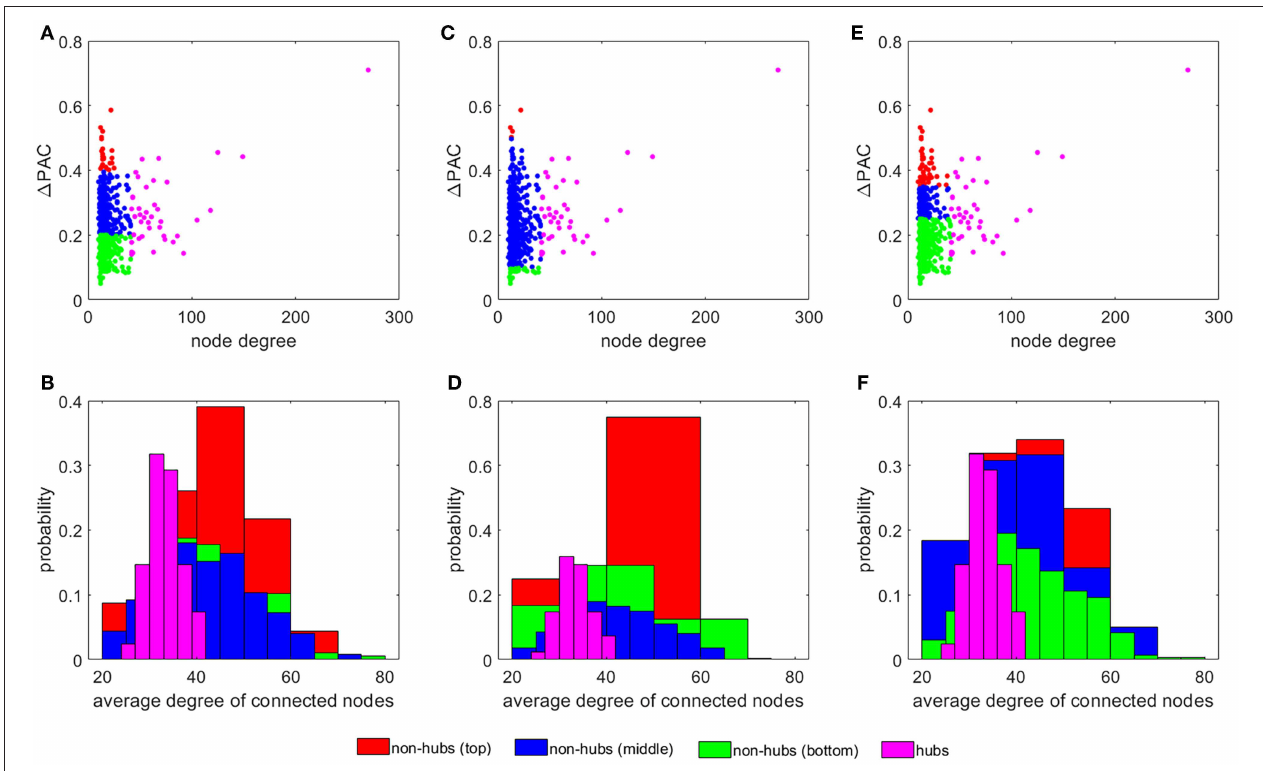
FIGURE 4 | The influence of non-hubs vs. hubs on 1 PAC . Average 1 PAC for each node degree for three different grouping of non-hubs: (A) bottom ( 0 − 0.2 ) , middle ( 0.2 − 0.4 ) , and top ( 0.4 − 0.6 ) , (C) bottom ( 0 − 0.1 ) , middle ( 0.1 − 0.5 ) , and top ( 0.5 − 0.6 ) , and (E) bottom ( 0 − 0.25 ) , middle ( 0.25 − 0.35 ) , and top ( 0.35 − 0.6 ) . Panels (B,D,F) present the probability of the four different groups of nodes of connecting to nodes of certain degrees, corresponding to the node distribution presented in panels (A,C,E) , respectively.